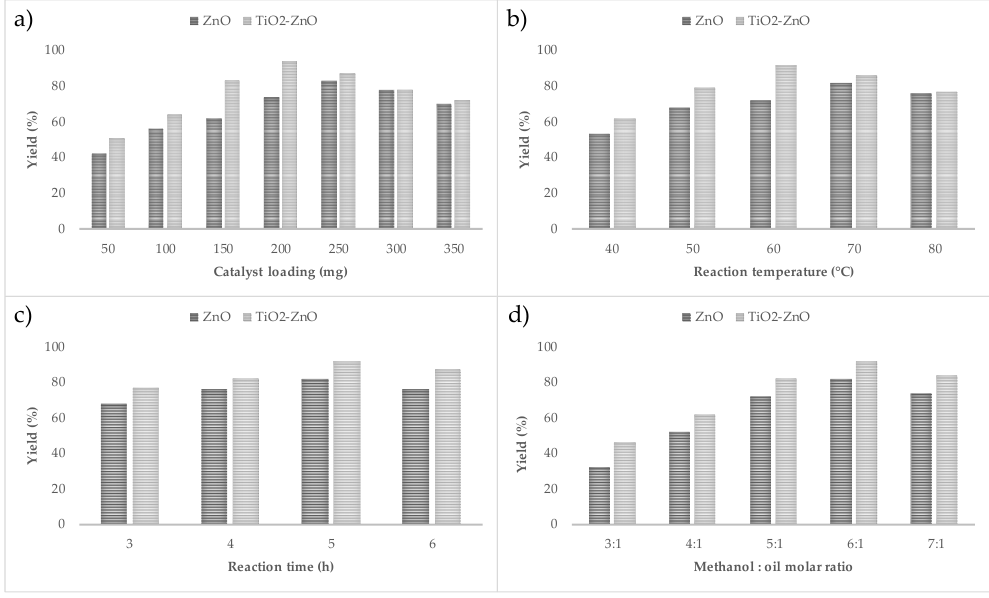
Figure 11. Effect of experimental parameters on FAME conversion: ( a ) catalyst loading, ( b ) temperature, ( c ) time and ( d ) methanol/oil molar ratio.